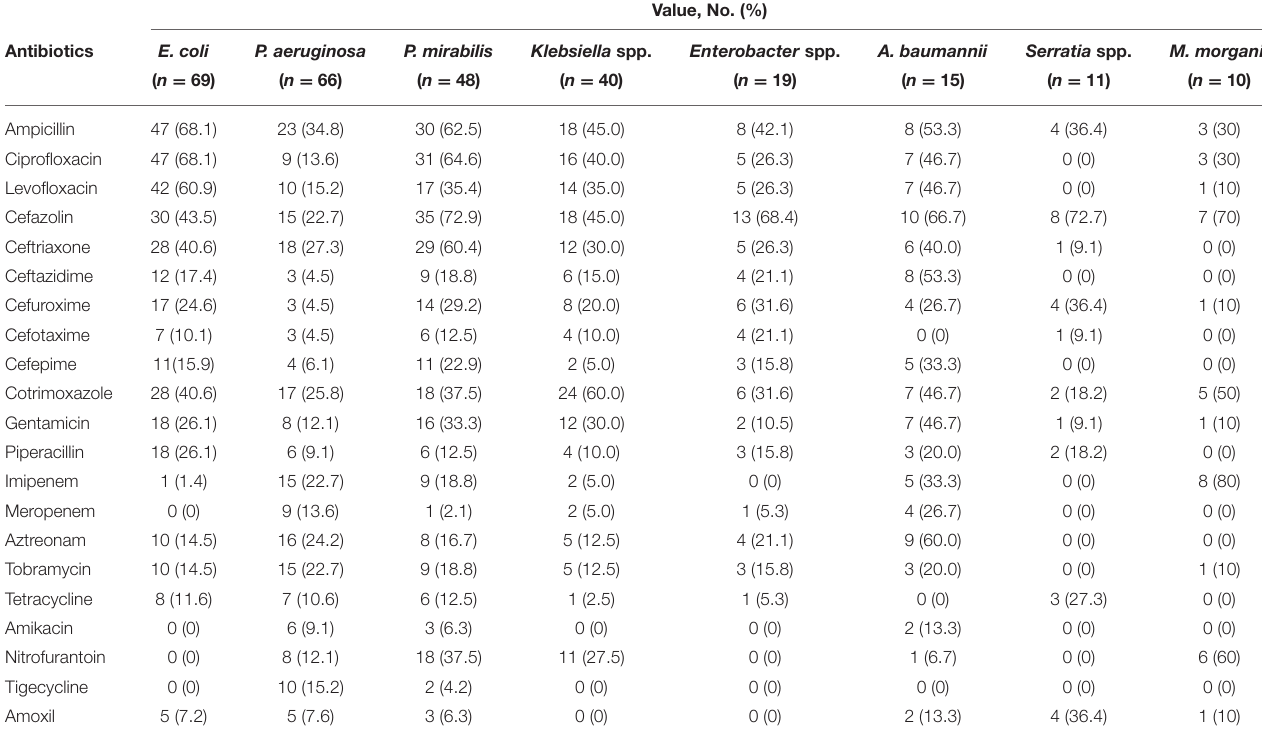
TABLE 5 | Drug resistance patterns of Gram-negative pathogenic bacteria.